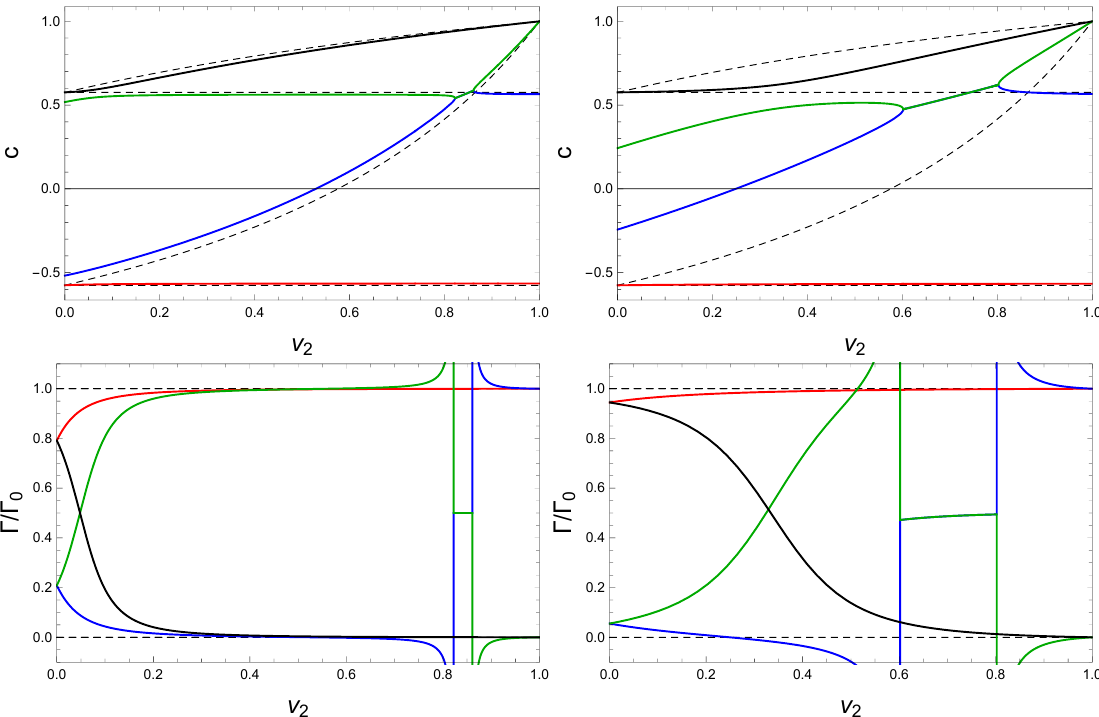
Figure 3. Real parts of the sound speeds c ( upper panels ) and corresponding attenuation Γ ( lower panels, with corresponding colors ) for upstream ( c < 0) and downstream ( c > 0) modes as a function of the velocity of the non-dissipative fluid v 2 in the rest frame of the dissipative fluid, for weakly coupled fluids ( left panels ) and strongly coupled fluids ( right panels ). See text for the choice of parameters. Thin dashed lines are the modes in the uncoupled system. The main result is the change of sign of Γ and thus the onset of a dynamical instability at the point where one of the modes ( blue ) flips over from upstream to